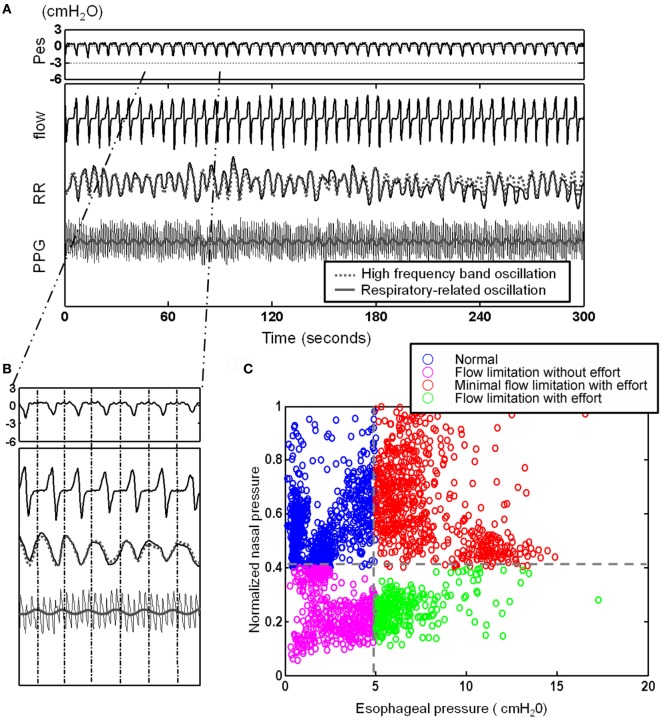
After defining the oscillations related to the respiratory-related RR oscillation [see (A)], here, presentation of a 5 min recording with illustration of cycle-based analysis: (A) 5 min segment of esophageal pressure (Pes), RR intervals (RR), photoplethysmogramy (PPG) signal, and nasal flow. Note the elicited respiratory-related oscillations of RR (gray dotted line) and PPG (gray line) by Hilbert–Huang transform. (B) Identification of corresponding Pes and nasal pressure cycle by cycle and quantification of cycle-based parameters: we obtained a physiologically defined cycle-based analytic tool allowing quantification of the oscillations contained within and extracted from each breath-cycle. (C) Four different subgroups can be identified and classified: an increase in respiratory effort indicated by more negative Pes can be associated with flow limitation or normal flow (“compensated flow” see text).